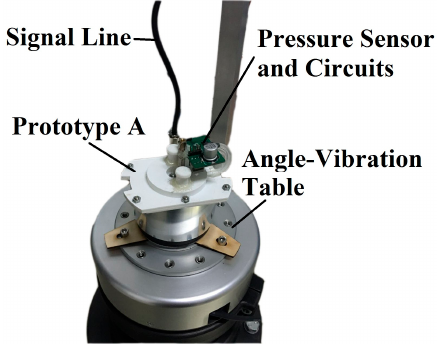
Figure 9. Experiments of Prototype A on the angle-vibration table.